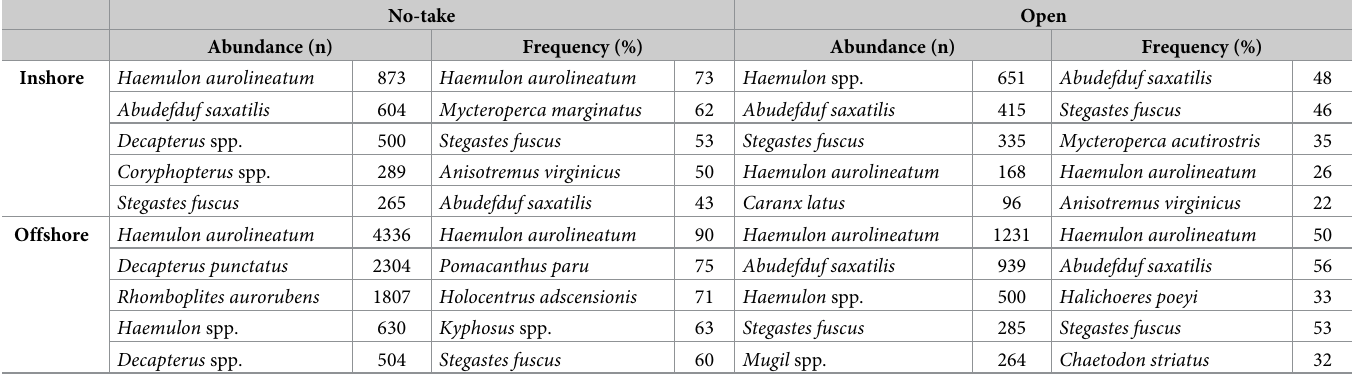
Table 2. Top five most abundant and frequent species (% of samples a species was observed) in no-take and open to fisheries areas in inshore and offshore regions.